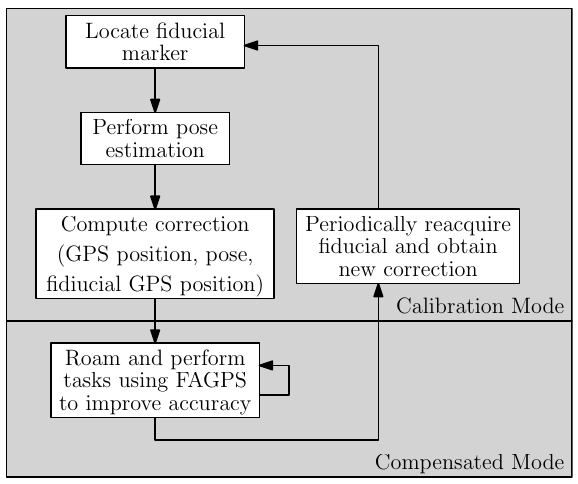
Figure 2. FAGPS Operational Flow